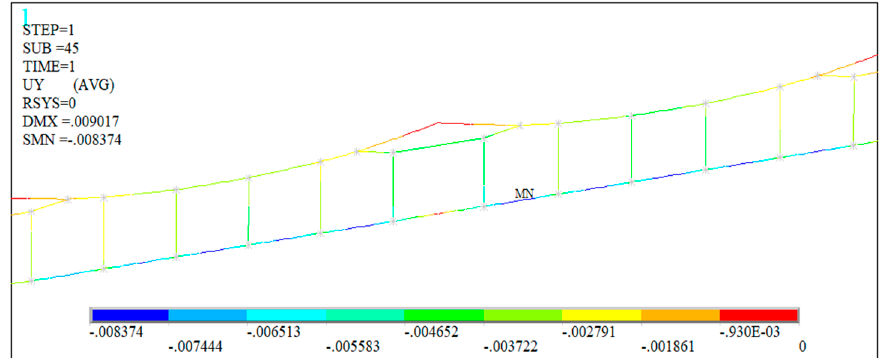
Figure 15. FEM of the railway catenary (the span where the central anchor was located).